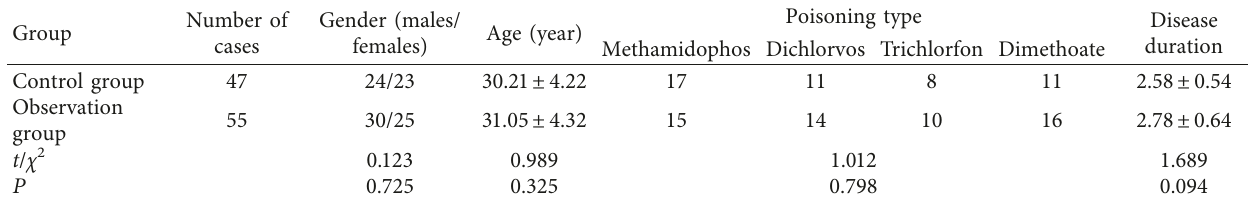
Table 1: Comparison of general data of two groups of patients ( n , x ± s